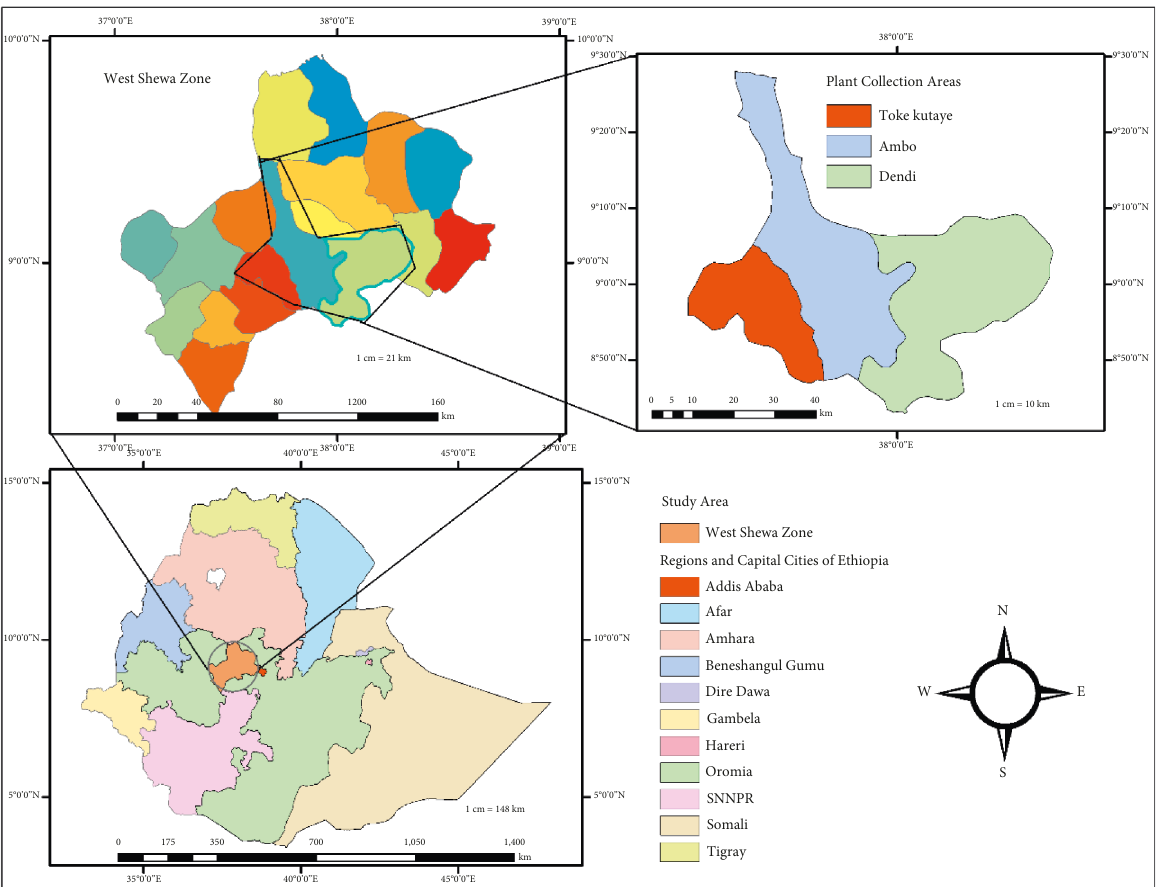
Figure 1: Map of the study